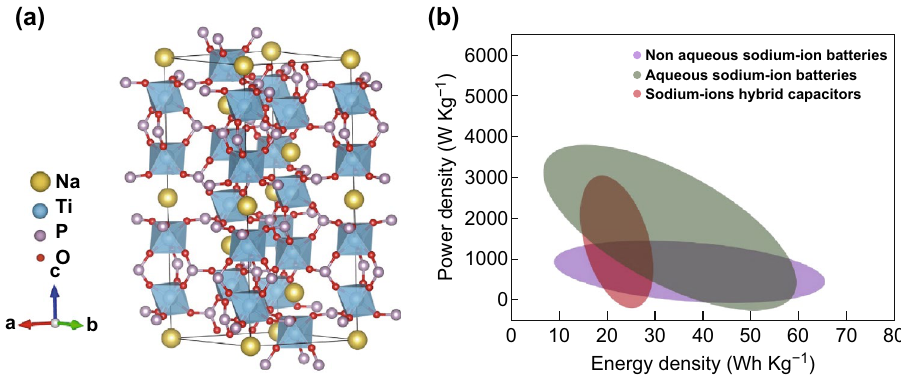
Fig. 1 a Crystal structure of NaTi 2 (PO 4 ) 3 and b Ragone plot of NaTi 2 (PO 4 ) 3 -based materials for non-aqueous sodium-ion batteries, aqueous sodium-ion batteries, and sodium-ion hybrid capacitors [32, 43, 44, 46, 95, 127, 131, 132, 159, 164, 165,